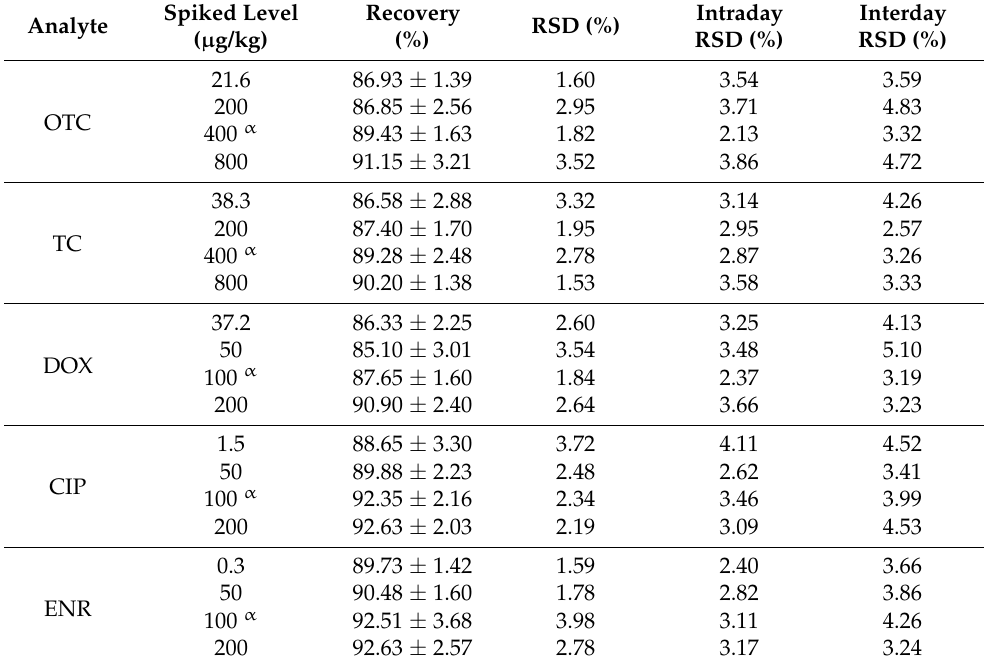
Table 7. Recovery and precision for analyses of blank duck yolk spiked with OTC, TC, DOX, CIP and ENR (n =